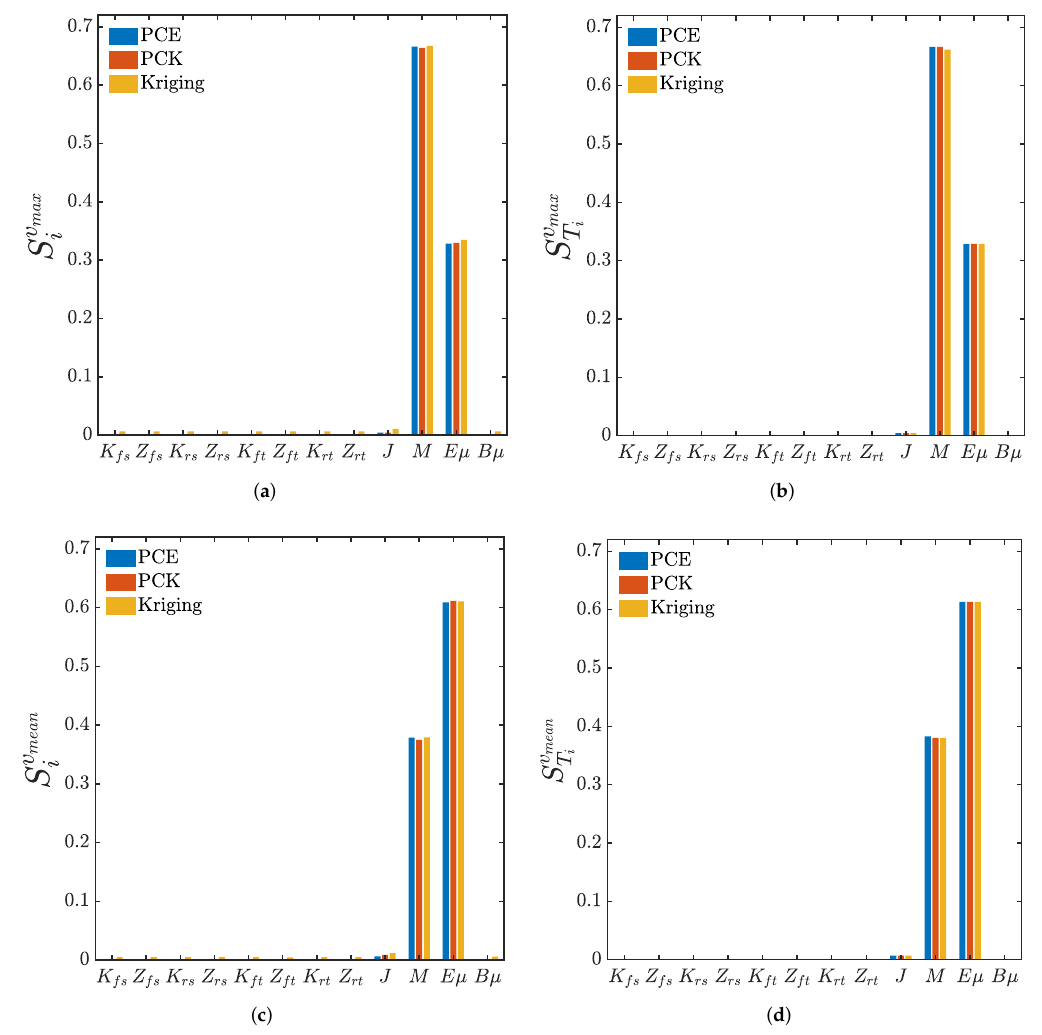
Figure 11. First-order and total Sobol’ indices for ( a , b ) v max and ( c , d ) v mean